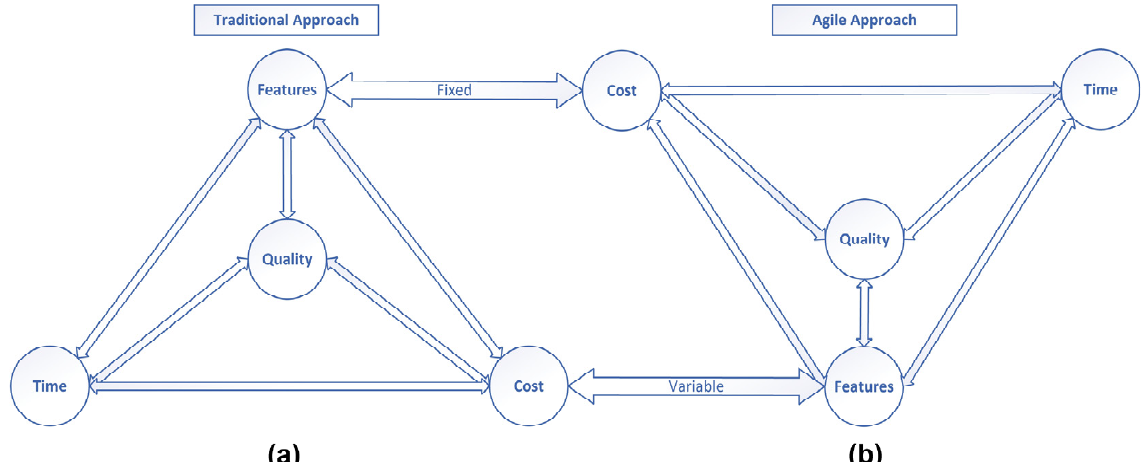
Figure 1. Iron triangle: ( a ) traditional approach, ( b ) Agile approach.